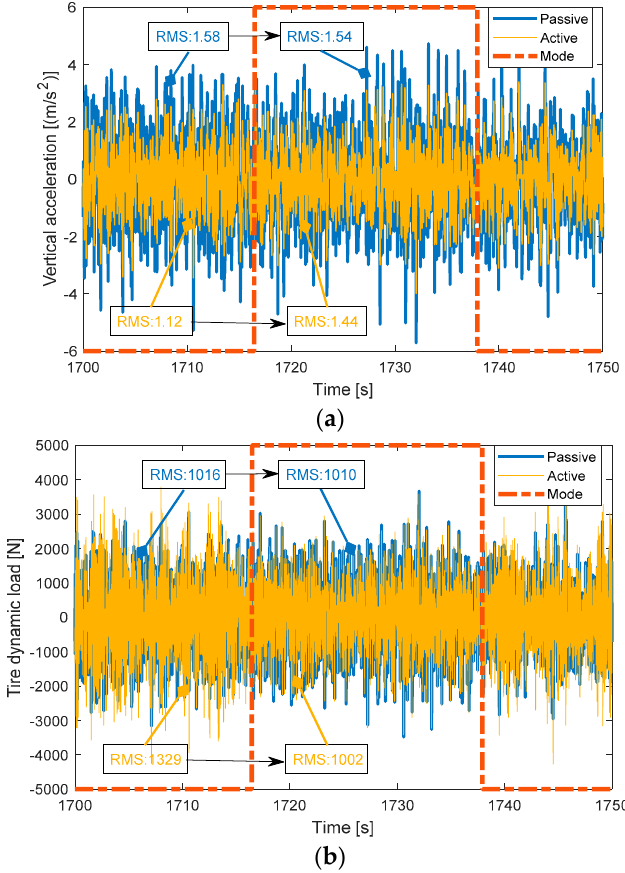
Figure 9. The time responses of regenerative suspension and passive counterpart. ( a ) Vertical acceleration of the vehicle body; ( b ) tyre dynamic load. Table 4. Comparison of dynamic performance improvement before and after the mode switching.